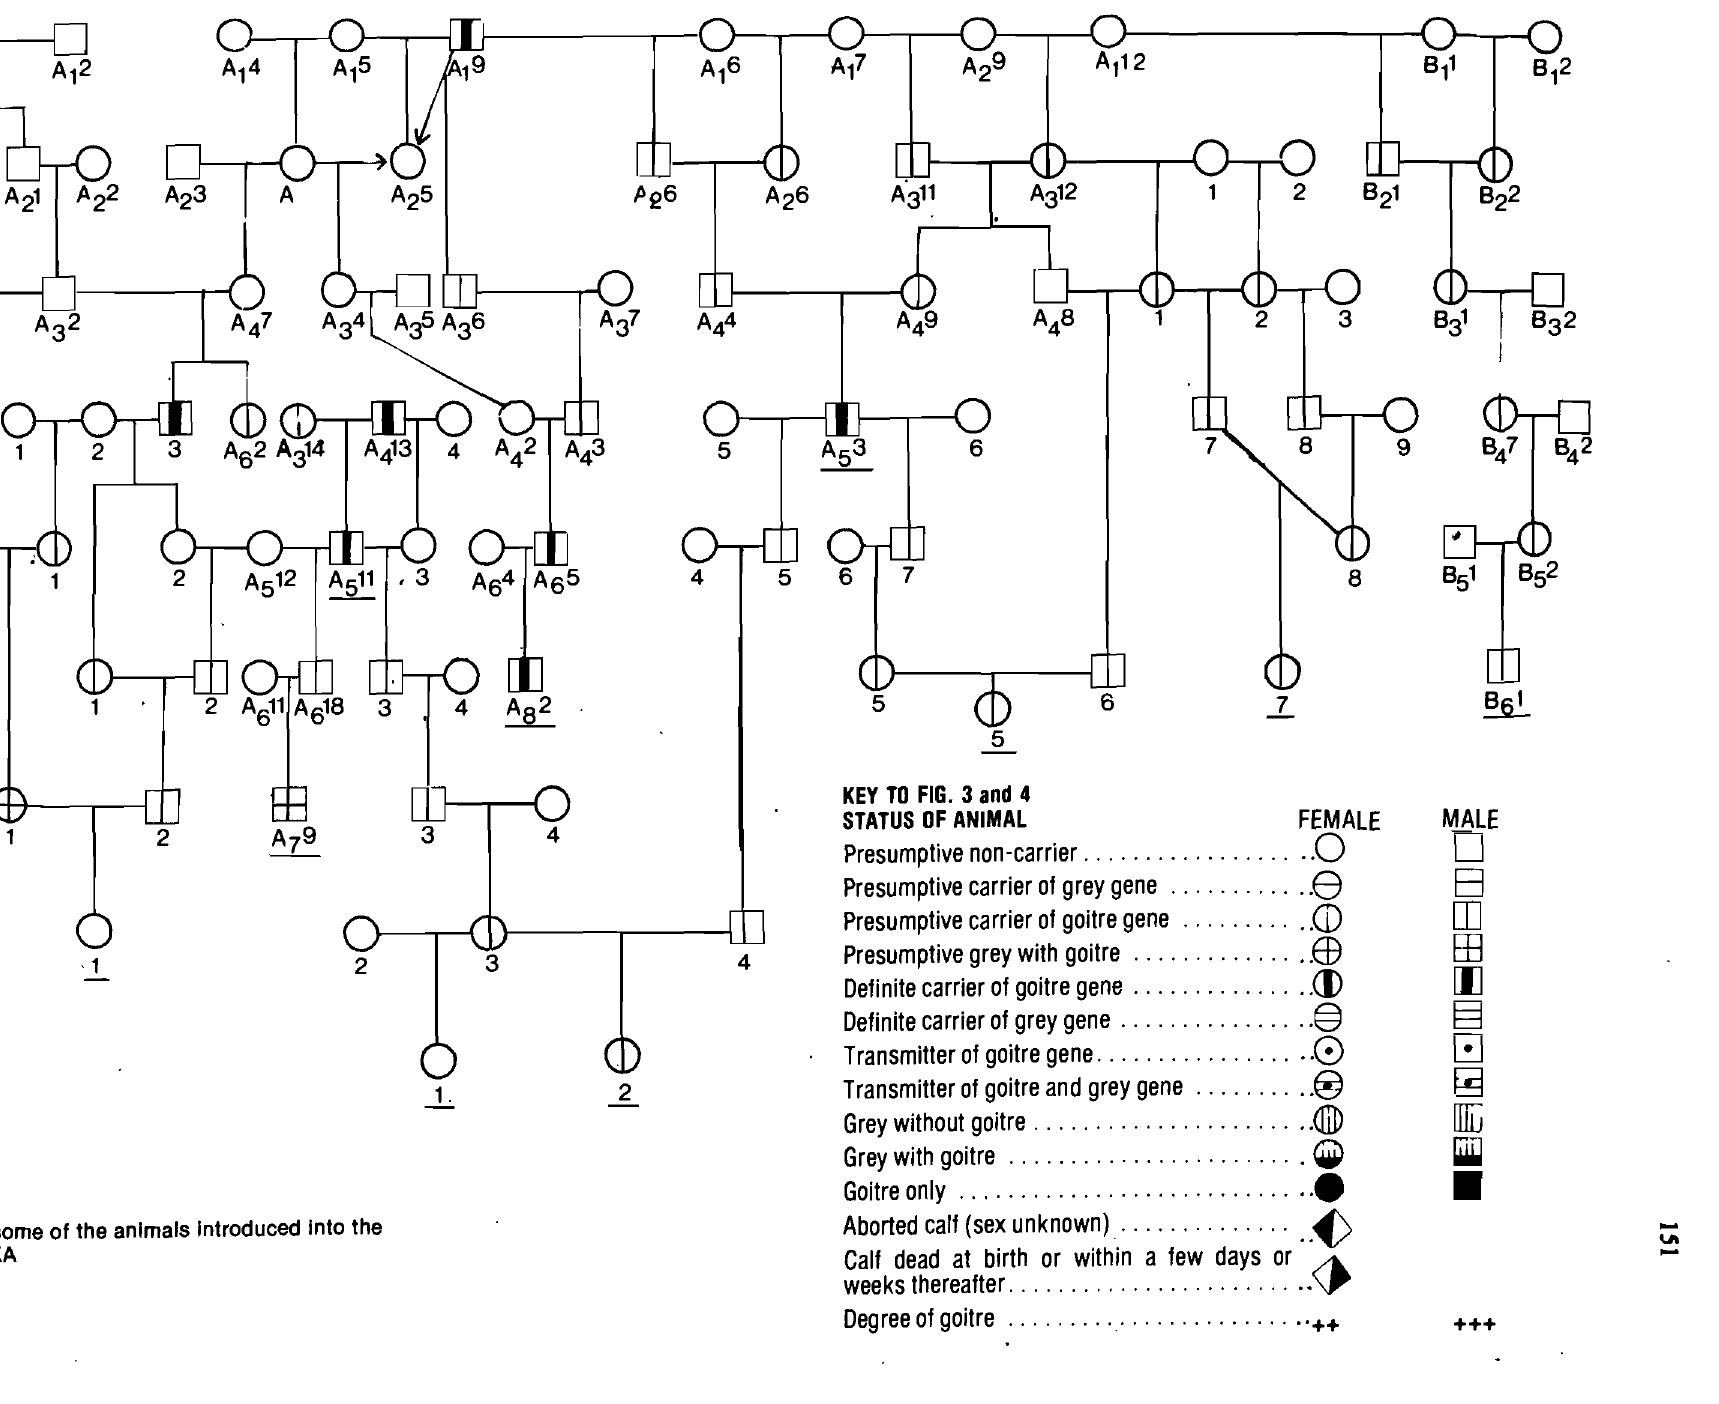
Fig. 4: Genealogy of some of the animals Introduced Into the herd. on farm